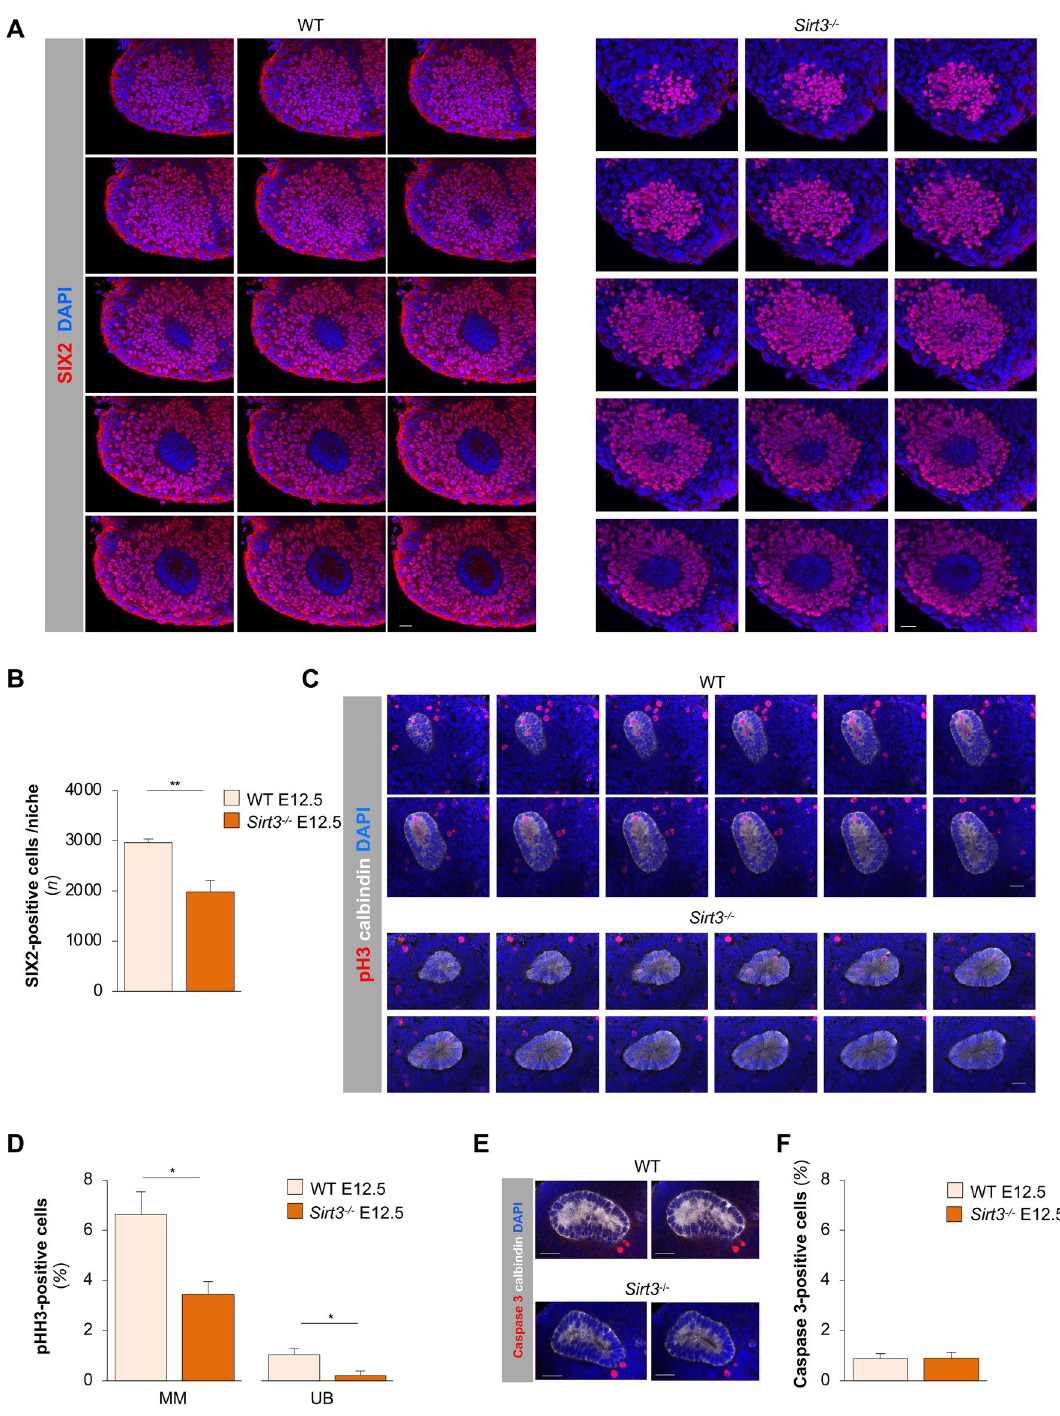
Figure 5. SIX2-positive progenitor cell number and proliferation decrease in Sirt3 −/− metanephroi. ( A ) Representative confocal z stack series of individual niche of E12.5 metanephroi stained for SIX2 (red) and DAPI (blue). Scale bars, 20 µm. ( B ) Quantification of the numbers of SIX2-positive cells in E12.5 metanephroi in WT and Sirt3 −/− mice. SIX2-positive cells were counted in z stack optical sections acquired through each single niche ( n = 5 mice per group). ( C ) Representative confocal z stack series of individual niche of E12.5 metanephroi stained for phospho-Histone H3 (pH3, red), calbindin (white) and DAPI (blue). Scale bars, 20 µm. ( D ) Quantification of cell proliferation in metanephric mesenchyme (MM) and UB of E12.5 metanephroi in WT and Sirt3 −/− mice. The percentage of phospho-histone H3 (pH3)-positive cells has been quantified in whole metanephros ( n = 6 mice per group). ( E ) Representative images of two different z-stack sections of E12.5 metanephroi stained for Caspase 3 (red), calbindin (white) and DAPI (blue). Scale bars, 20 µm. ( F ) Quantification of apoptosis in E12.5 metanephroi from WT and Sirt3 −/− mice by counting Caspase 3-positive cells ( n = 6 mice per group). Data represent mean ± s.e.m. and were analysed with Student’s t -test. * P < 0.05, and ** P <